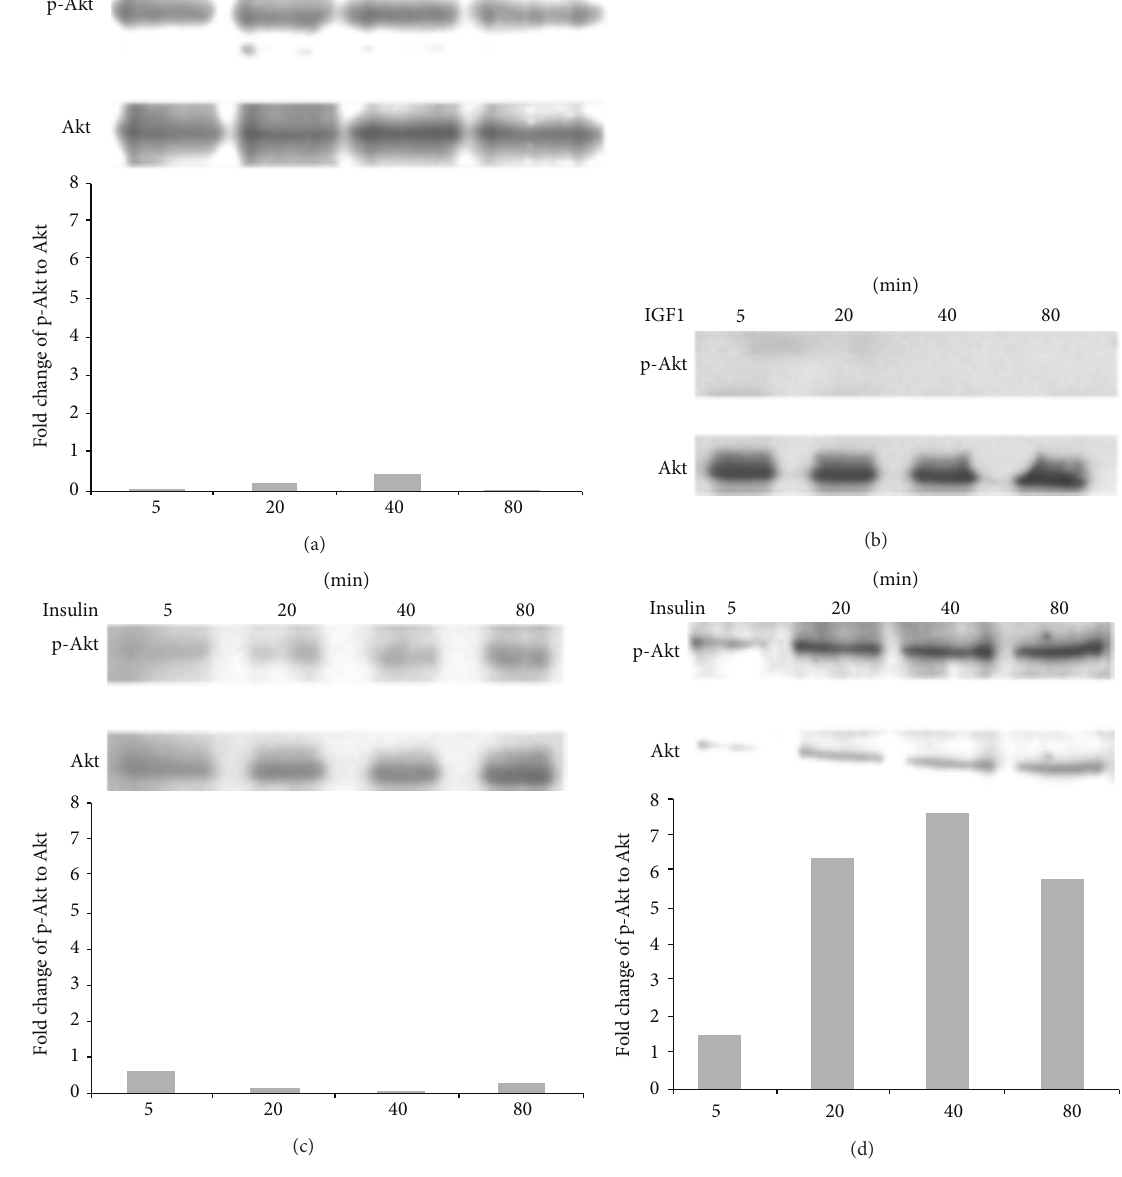
Figure 4: Loss of the IGF-1R enhances sensitivity to insulin-induced (a) and IGF1 (b) Akt phosphorylation. barrier. However, 7 mice in wild-type mice fed with high- sugar high-fat treatment group had three in a serious cog- nitive disorder. Until testing the latter (25w), the living state of all wild mice was not suitable for water Morris maze test, while no knock-down (IGF-1R neo ) mice still have the athletic ability and cognitive